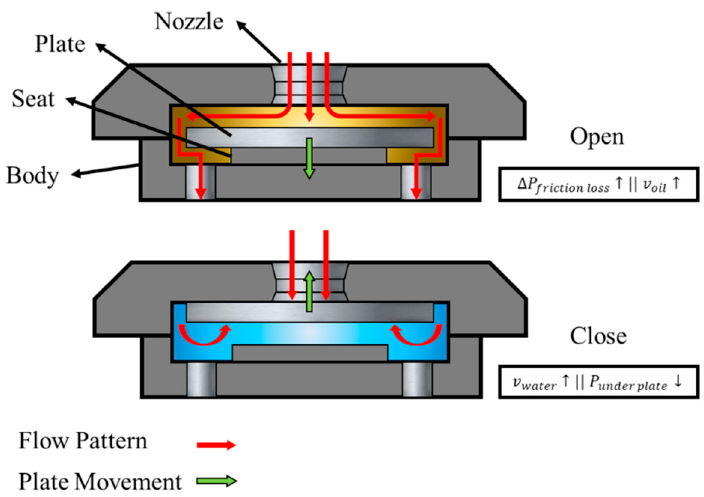
Figure 3. Typical RCP design. The flow patterns and the plate movement for the open and closed positions are also shown. Additionally, the principle behind the plate movement is based on Bernoulli’s principle.